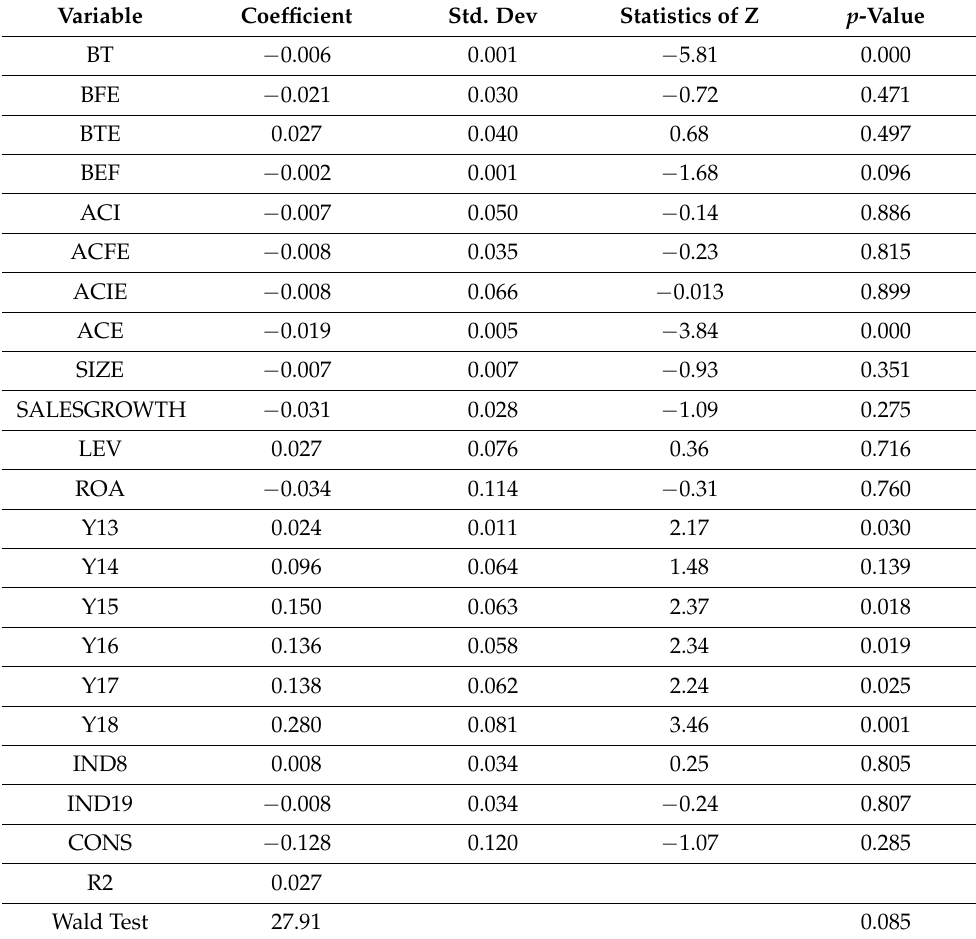
Table 15. The results of the T + 1 regression estimation of model one by the fixed effects approach.